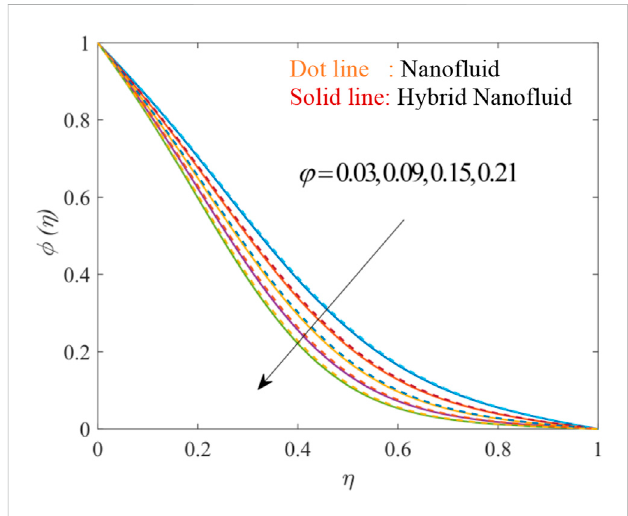
FIGURE 19 Effect of Schmidt number Sc on ϕ ( η ) .